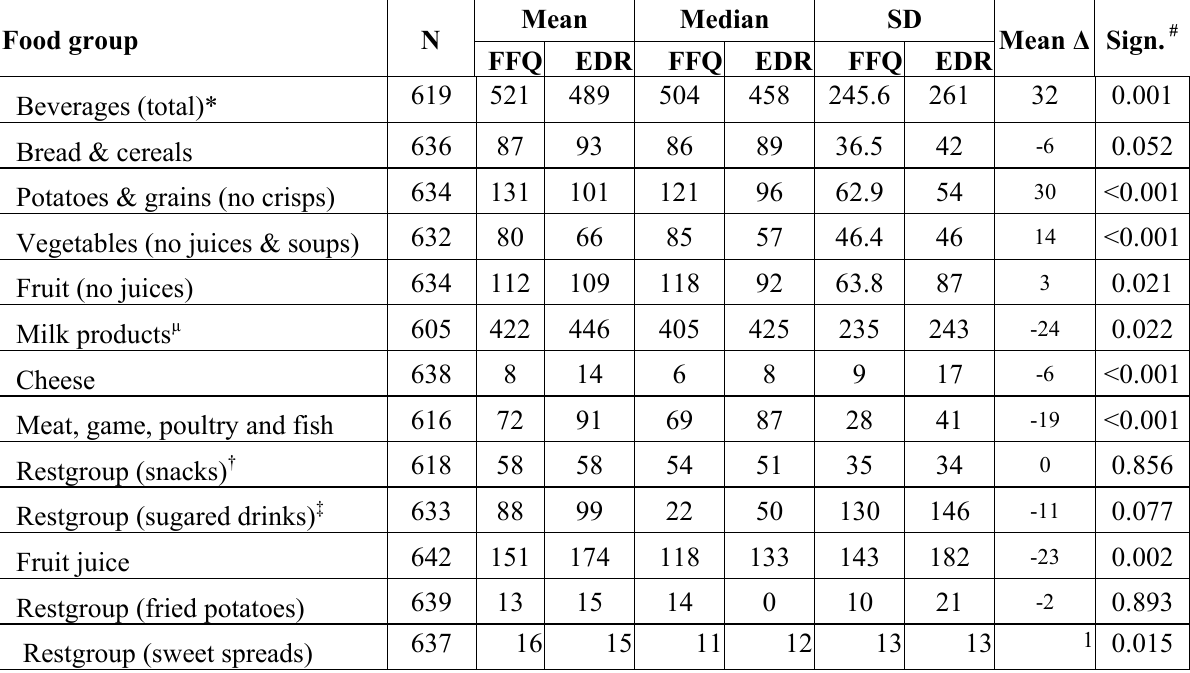
Table 4. Comparison of mean and median food (group) intakes estimated from the FFQ with mean and median intakes derived from the